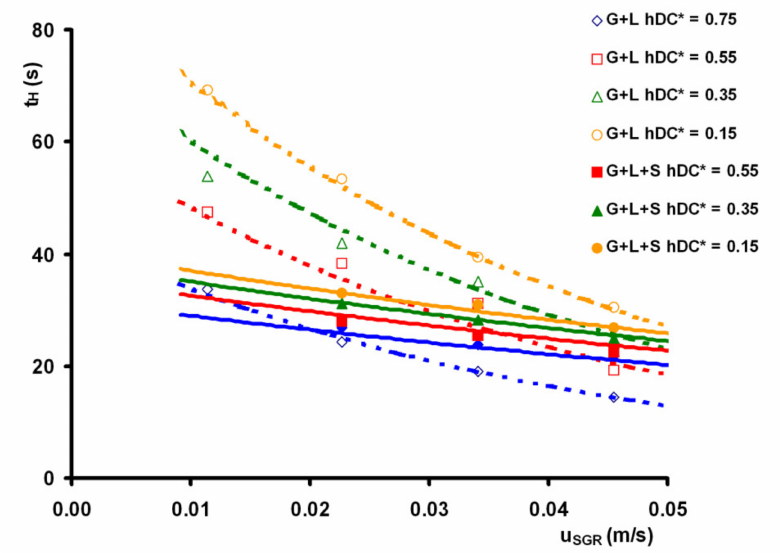
Figure 6. Homogenization time t H : Effect of riser superficial gas velocity: Gas–liquid system (empty symbols), gas–liquid–solid system (full symbols), correlation (7) for gas–liquid system (dotted line), correlation (7) for gas–liquid–solid system (full line).